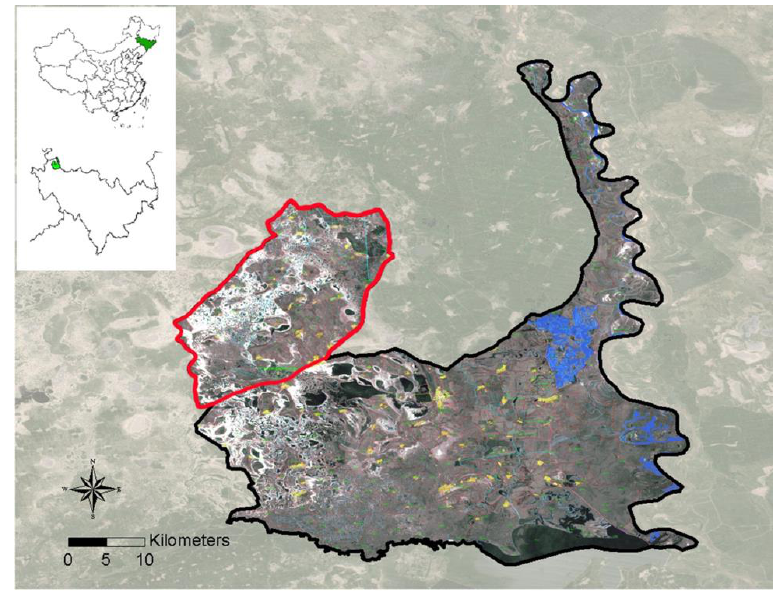
Figure 2. Location of the study area.